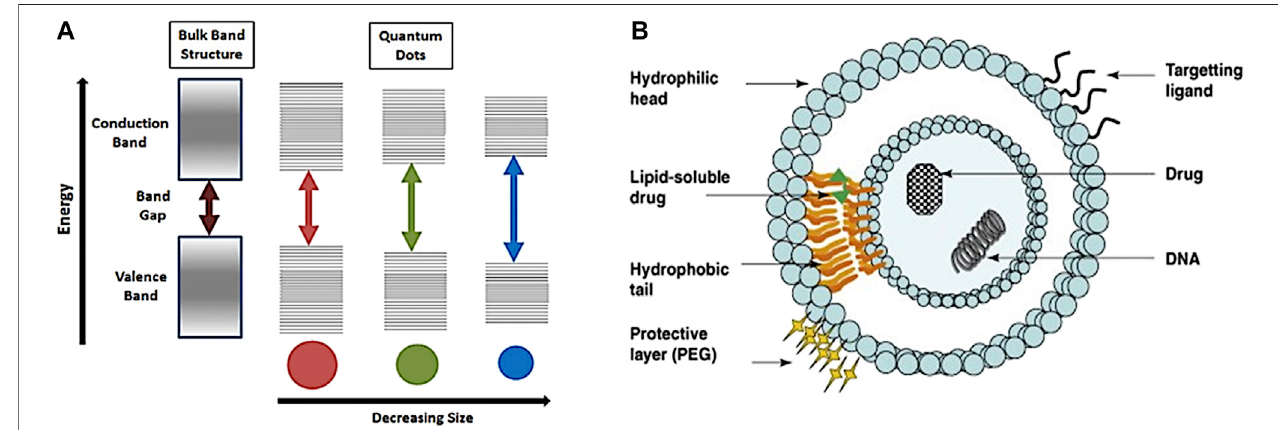
FIGURE 11 | (A) Electronic band gap of QDs with varying particle size. (Figure adapted from reference (McKittrick and Shea-Rohwer, 2014)), (B) Protected liposome structure by PEG polyether. (Figure adapted from reference (Malam et al.,